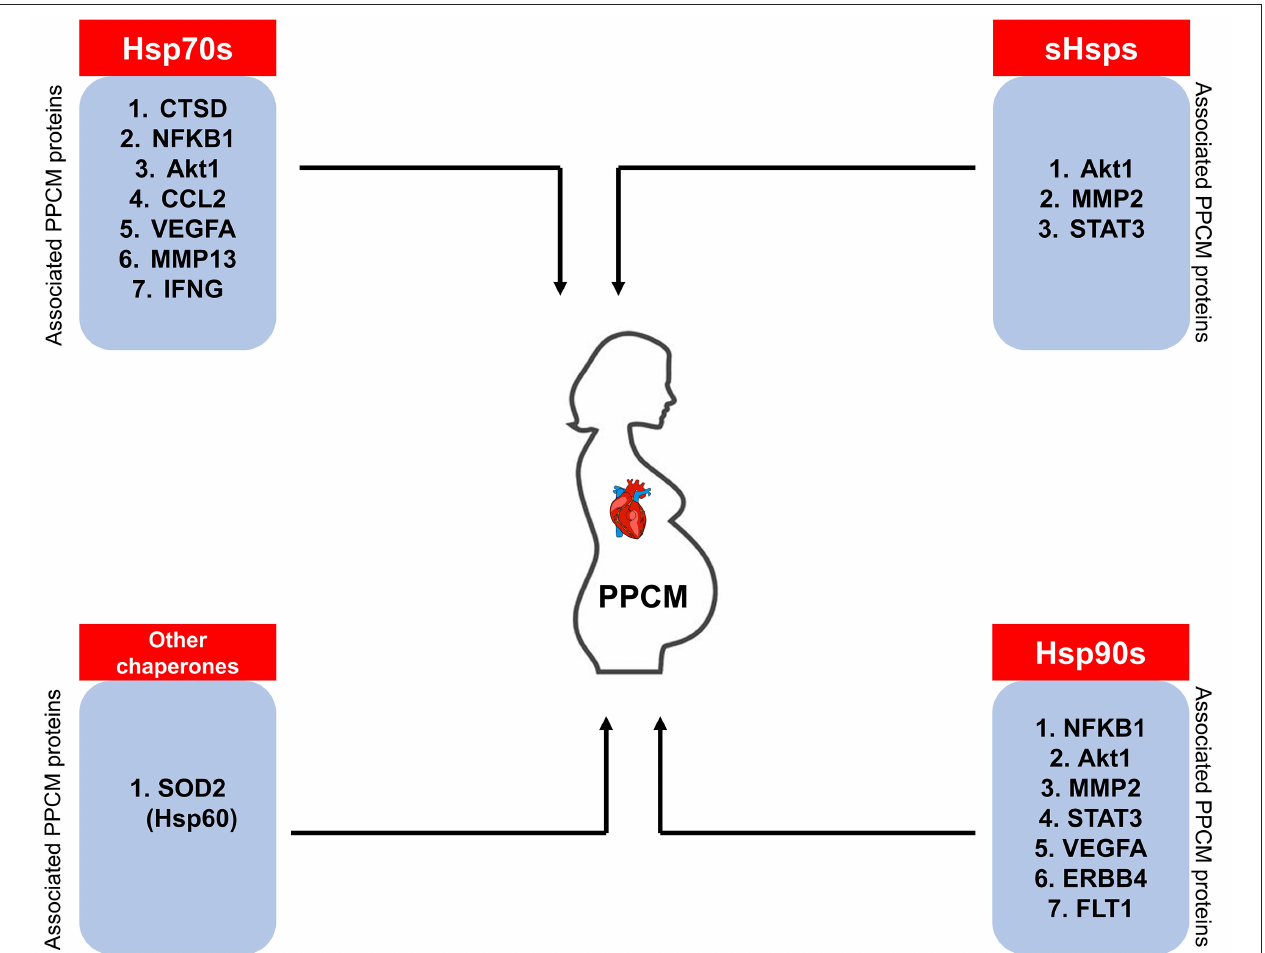
FIGURE 7 | Hsps as potential PPCM biomarkers. The Hsps (sHsps, Hsp60, Hsp70, Hsp90) predicted to associate with PPCM pathogenesis proteins may be used as candidate